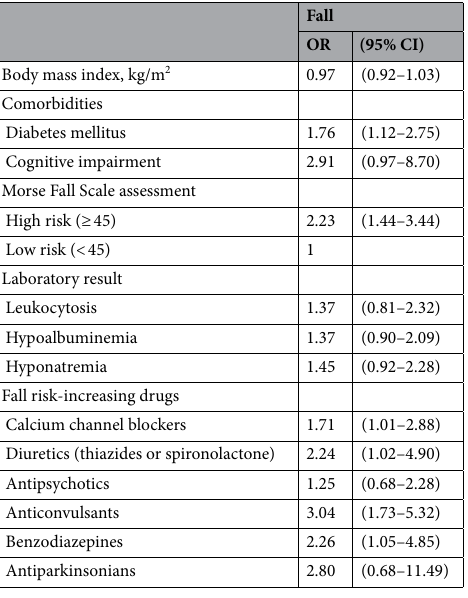
Table 4. Conditional logistic regression analysis of fall-related clinical factors. Odds ratio (OR) and 95% confidence interval (CI) by conditional logistic regression